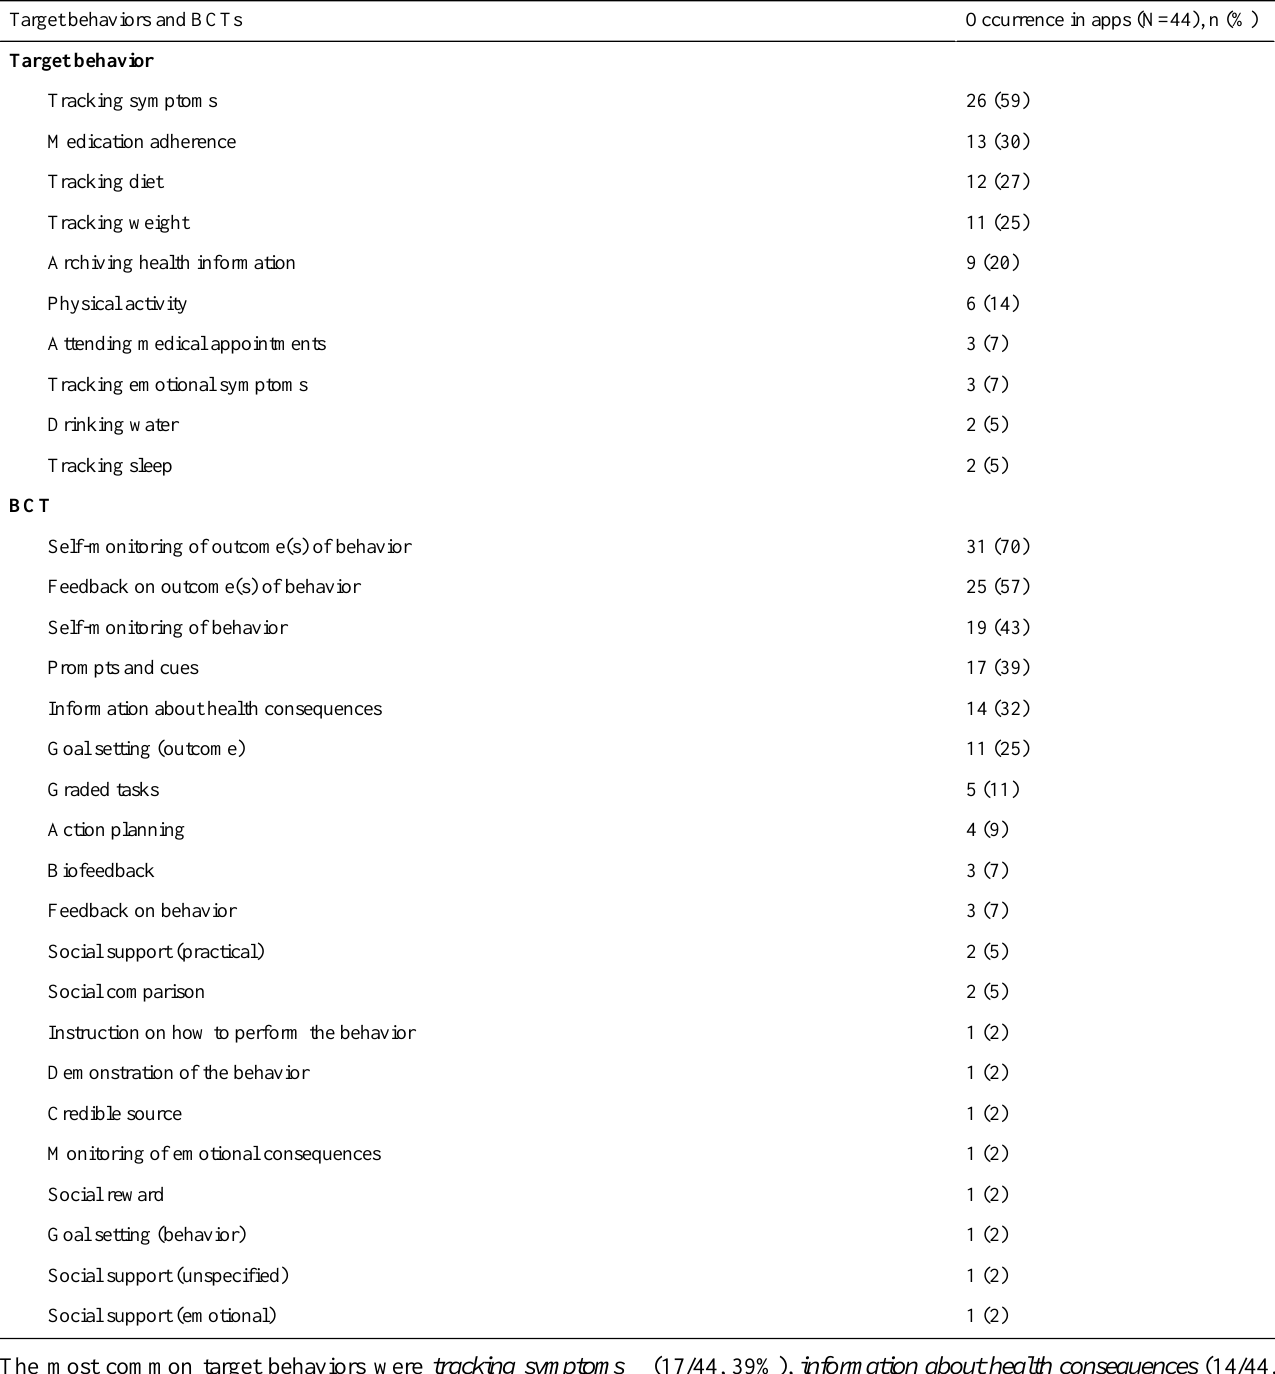
Occurrence in apps (N=44), n (%)Target behaviors and